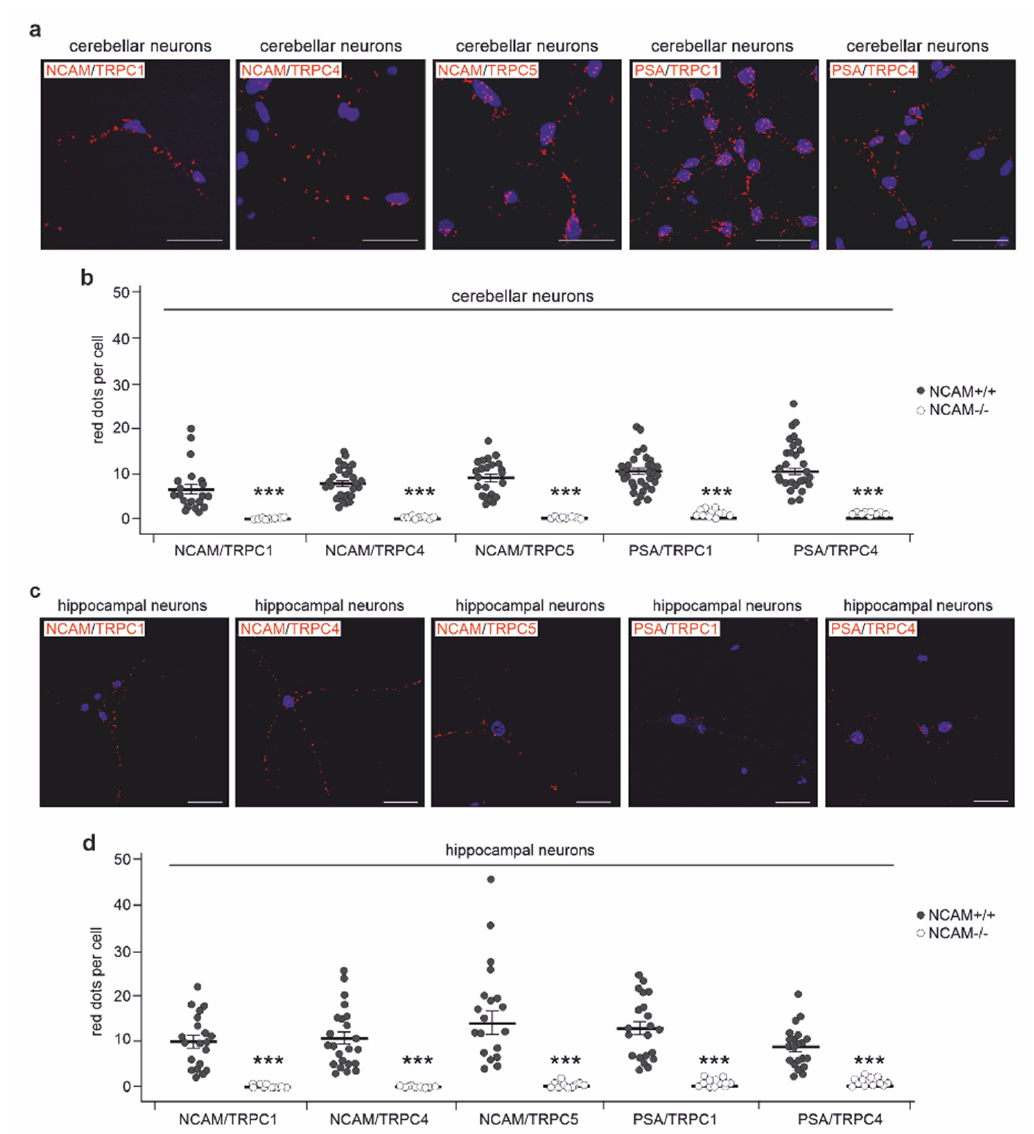
Nuclei were stained with DAPI (blue). ( a , b ) Representative images are shown for coimmunostaining of TRPC1 (red) and NCAM (green) or of TRPC1 (green) and PSA (red) in cerebellar ( a ) and hippocam- pal ( b ) neurons. Superimposition of red and green stainings shows colocalization in yellow. Scale bar: 20 µ m. ( c , d ) Pearson’s coefficients were determined from 10 immunostained neurons per group and from 2 different cultures. Box plots show the Pearson’s coefficients and indicate an overlap of NCAM or PSA stainings with TRPC stainings in cerebellar ( c ) and hippocampal ( d ) neurons.